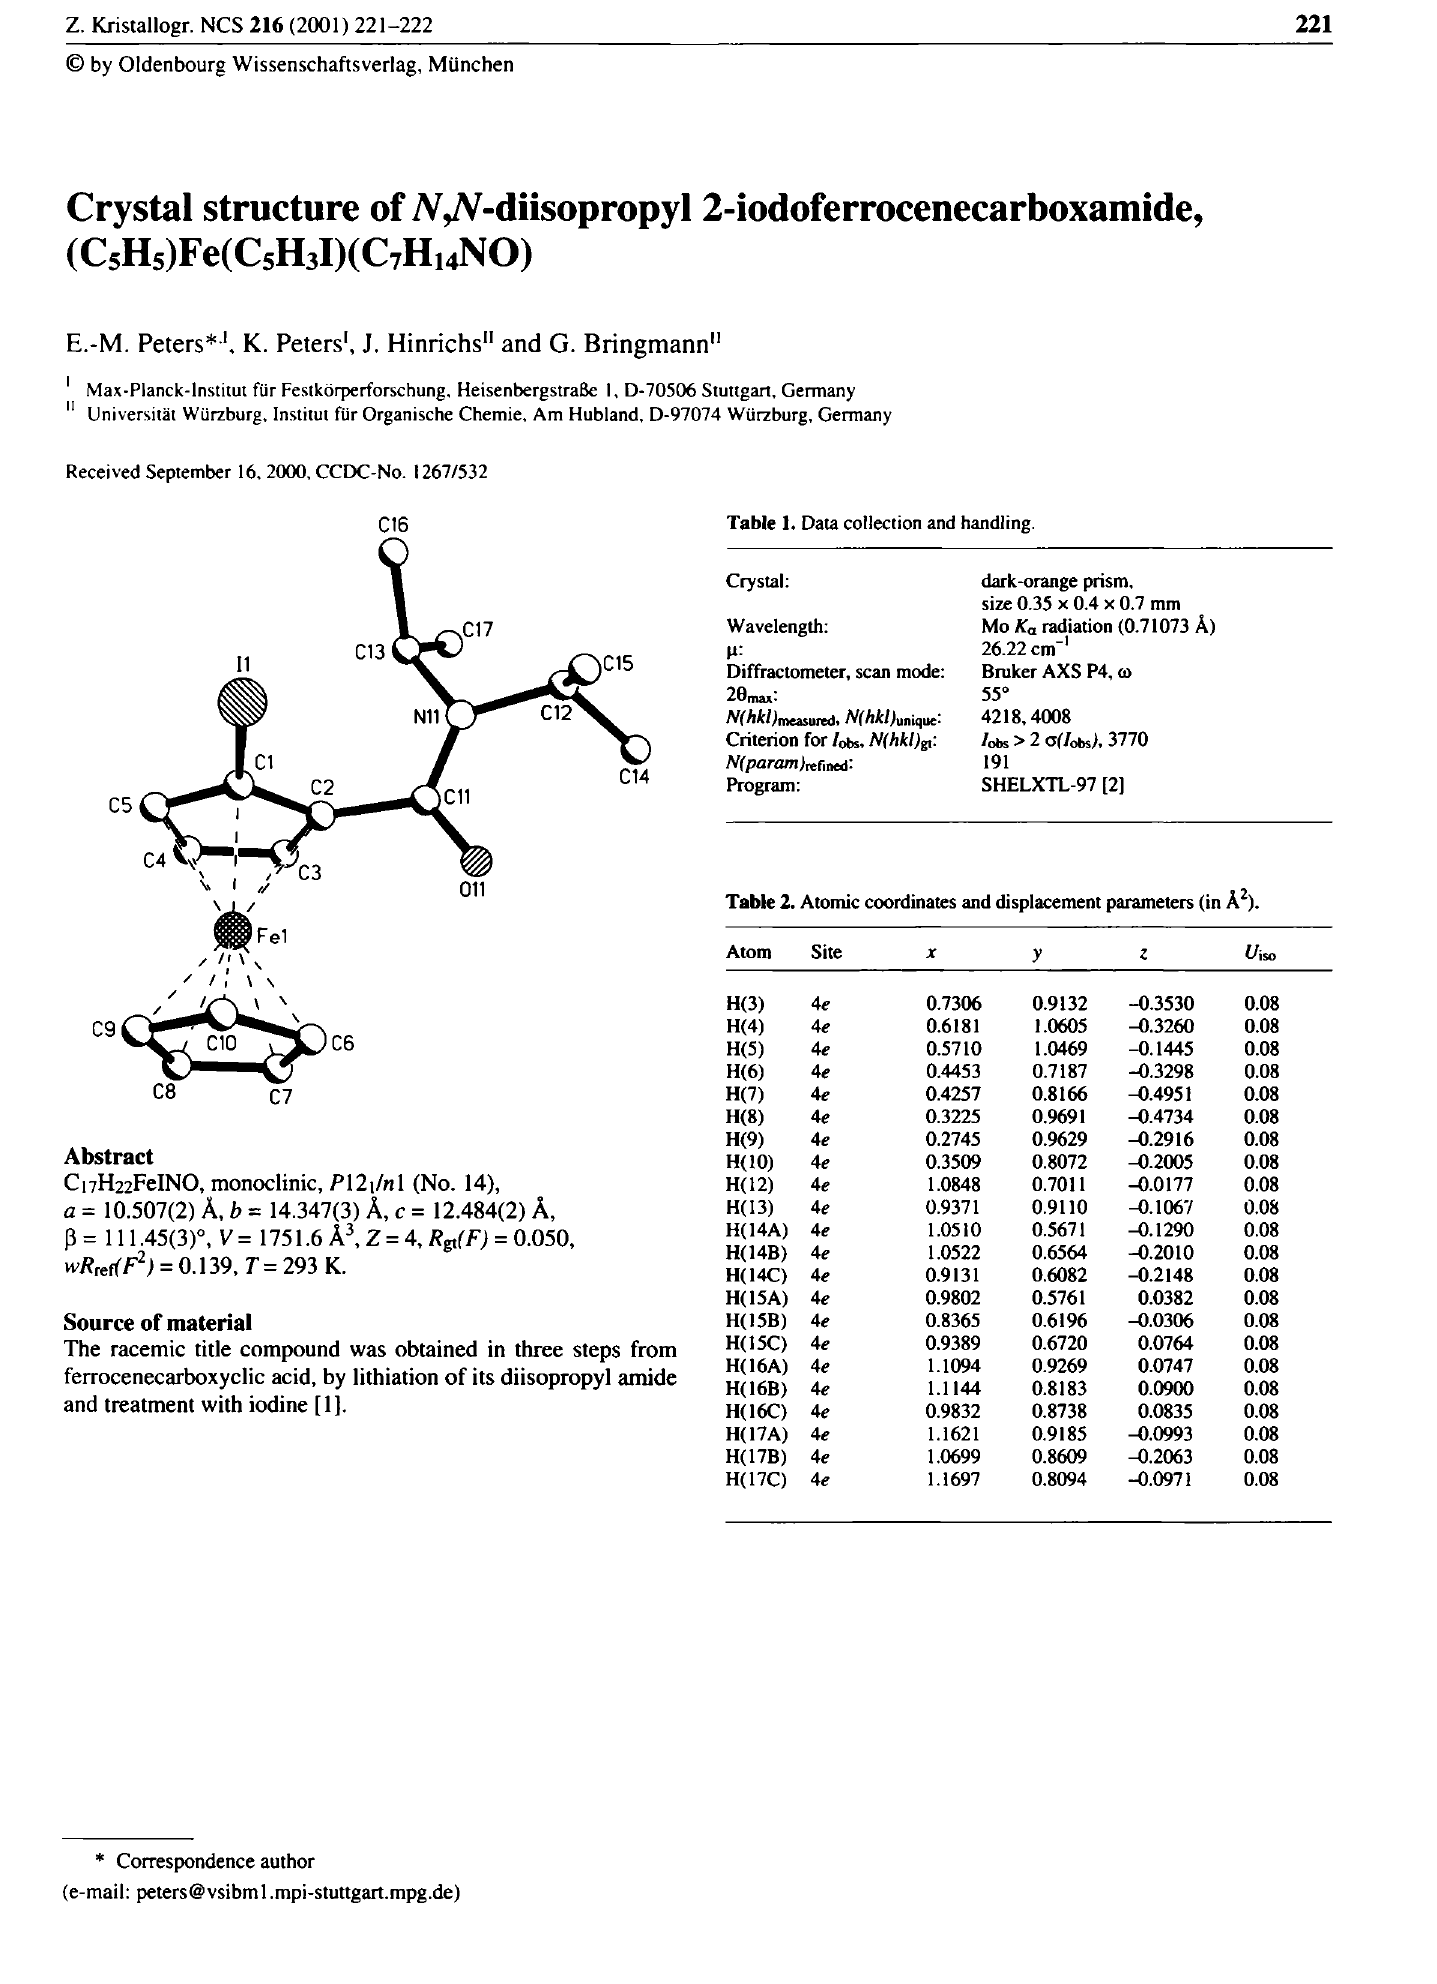
Table 1. Data collection and handling.